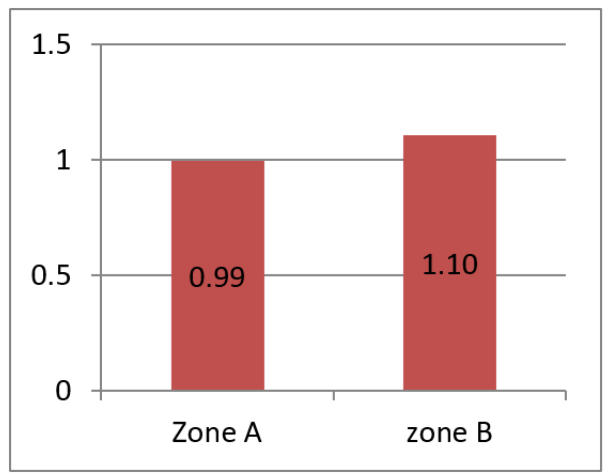
Figure 32. Average areas of front doors in Zone A and Zone B.